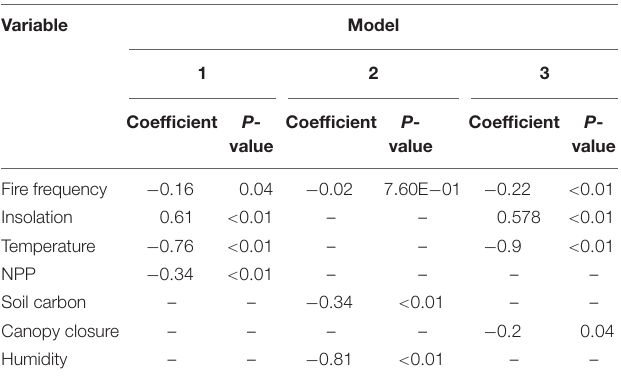
TABLE 3 | Coefficients of top three models from Table 1